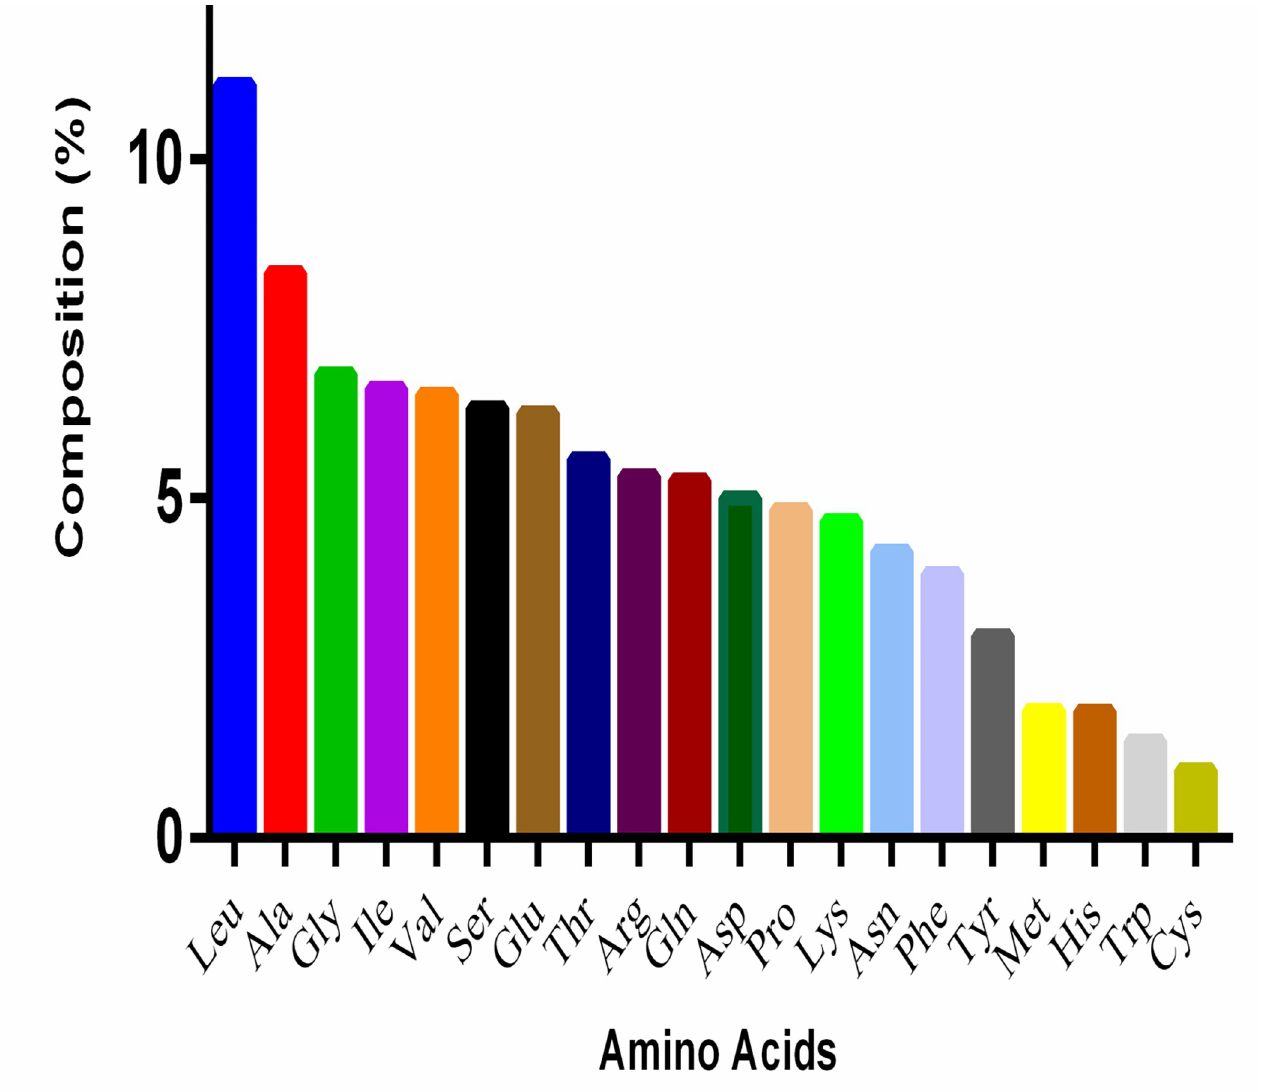
Fig 4. Average amino acid composition of cyanobacterial proteomes (%). Figure shows Leu is the highest and Cys is the lowest abundant amino acid in the cyanobacterial